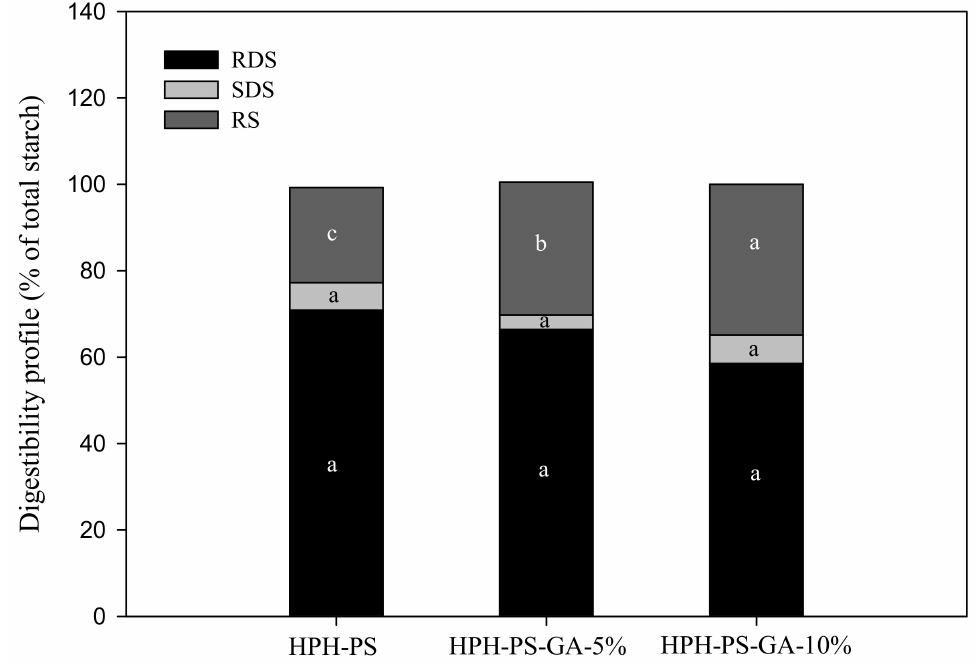
Figure 5. The in vitro starch digestibility of high-pressure homogenization-processed pea starch with 0% (HPH-PS), 5% (HPH-PA-GA-5%), and 10% (HPH-PA-GA-10%) gallic acid. Different letters in the same digestion category (i.e., RDS) indicate a significant difference at p <